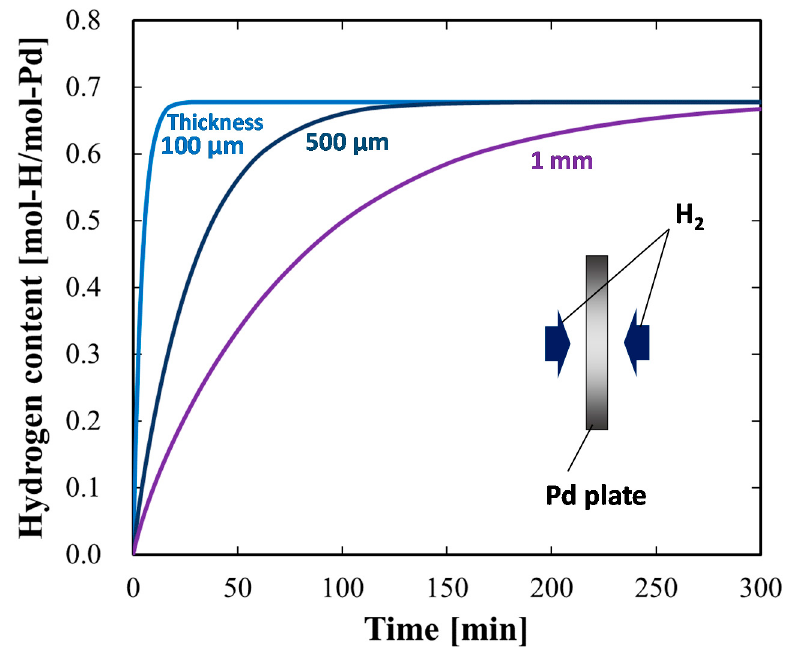
Figure 5. Simulated time evolutions of hydrogen content in Pd plates of various thicknesses.